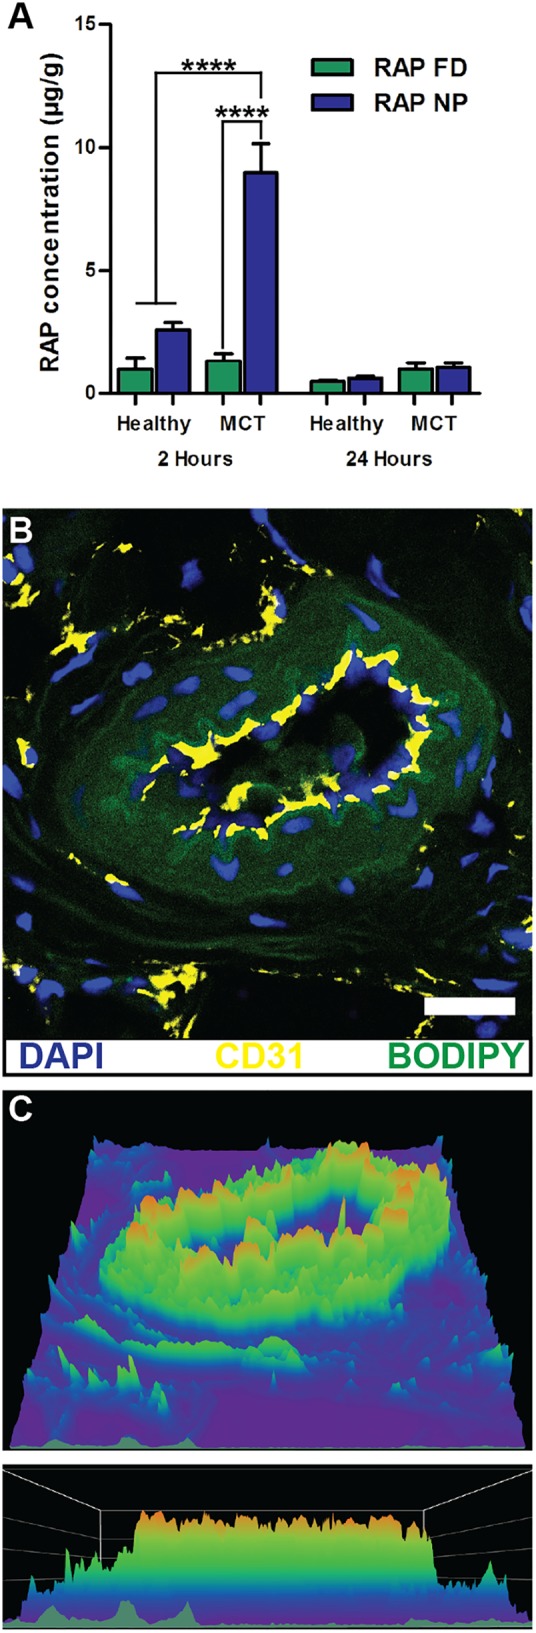
NP accumulation in PAH lung vasculature. (A) LC/MS analysis of rapamycin (RAP) concentration in lung tissues 2 and 24 h after a single administration of 15 mg/kg of RAP, either as a free drug formulation (RAP FD) or nanoparticle form (RAP NP) in healthy and MCT-induced model of PH in rats (PH). Results represent mean ± SEM (∗∗∗∗P < 0.0001). (B) Confocal imaging depicting fluorescently loaded NPs in diseased lungs. CD31 positive endothelial cells appear in yellow, NPs are green, while DAPI appears as blue. The scale bar represents 25 μm. (C) Surface intensity plot of the image from panel B representing NP signal. Figure adapted from Segura-Ibarra et al. (2017), reproduced with permission courtesy of Elsevier.